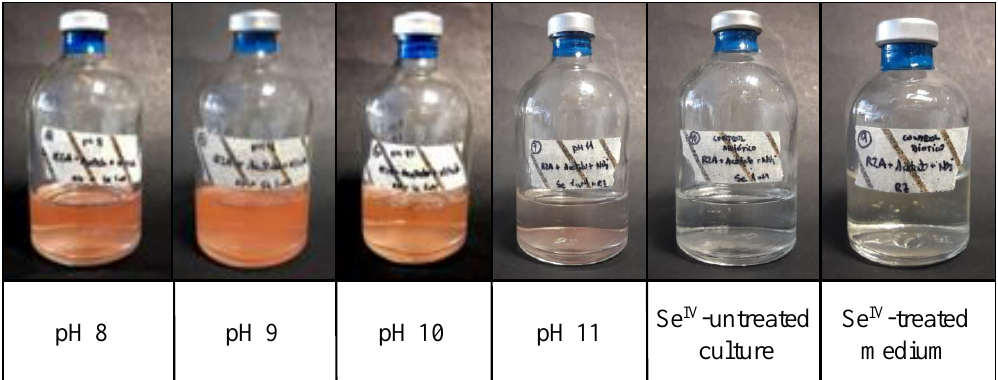
Figure 3. Cultures of S. bentonitica adjusted to pH 8, 9, 10, and 11 showing the reduction of 2 mM Se IV from pH 8 to 10, as indicated by their reddish colour. Se IV -untreated cultures and the Se IV -treated medium were employed as controls.